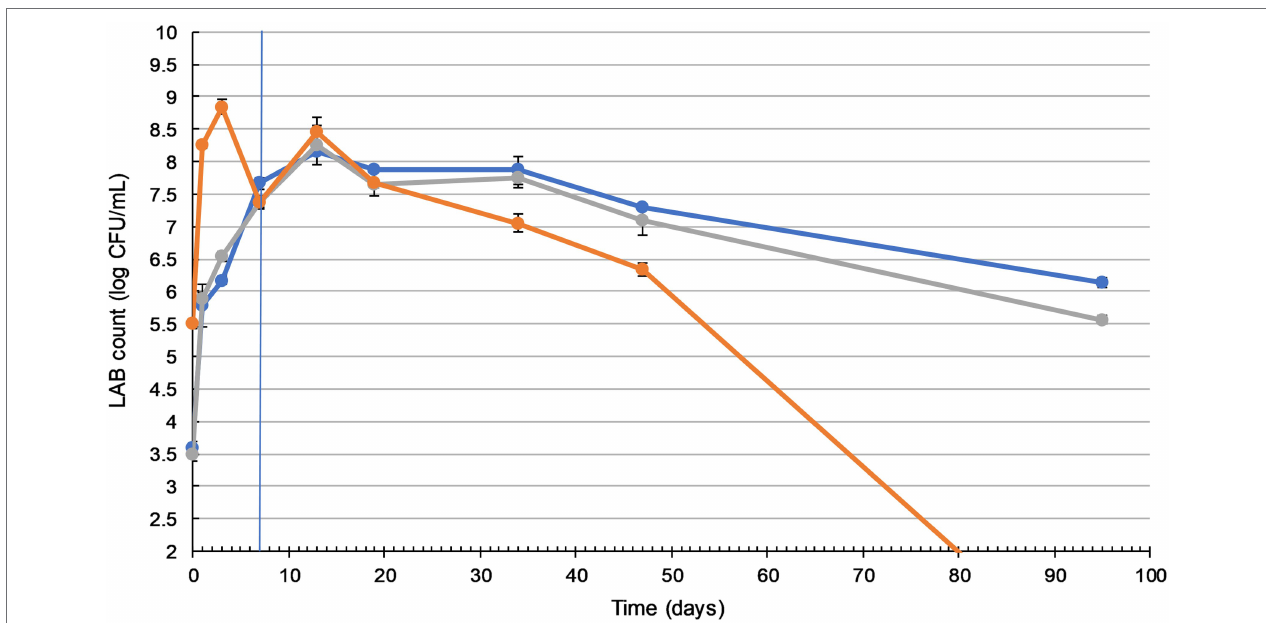
FIGURE 1 | Lactic acid bacteria (LAB) counts in sauerkraut remain sufficiently high during storage. Changes in LAB count during fermentation (20–25 ° C for 7 days) and storage (4 ° C for a further 88 days) of three sauerkraut treatments. ( ) spontaneous fermentation with 0.6% salt; ( ) spontaneous fermentation with 1.5% salt; ( ) inoculated fermentation with 0.91% ( w / w ) starter cultures and 0.6% salt. Sampled on days 0, 1, 3, and 7 (during fermentation), and on days 13, 19, 34, 47, and 95. The timeline of fermentation and storage is separated by the vertical blue line. The results were expressed as mean standard deviation ( n = 3) for each treatment